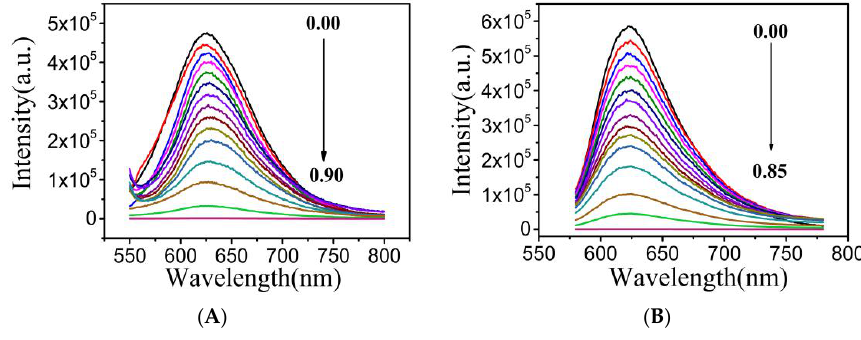
Figure 5. ( A ) Emission spectra of the NR-β-CD@AuNPs in the presence of different [NO 2− ] concentrations, including 0, 0.05, 0.10, 0.15, 0.20, 0.25, 0.30, 0.35, 0.40, 0.45, 0.50, 0.60, 0.70, 0.80, and 0.90 μg·mL −1 under a weakly alkaline medium; ( B ) Emission spectra of the NR-β-CD@AuNPs in the presence of different [NO 2− ] concentrations including 0, 0.05, 0.10, 0.15, 0.20, 0.25, 0.30, 0.35, 0.40, 0.45, 0.50, 0.60, 0.70, 0.80, and 0.85 µ g · mL − 1 under an acid medium.